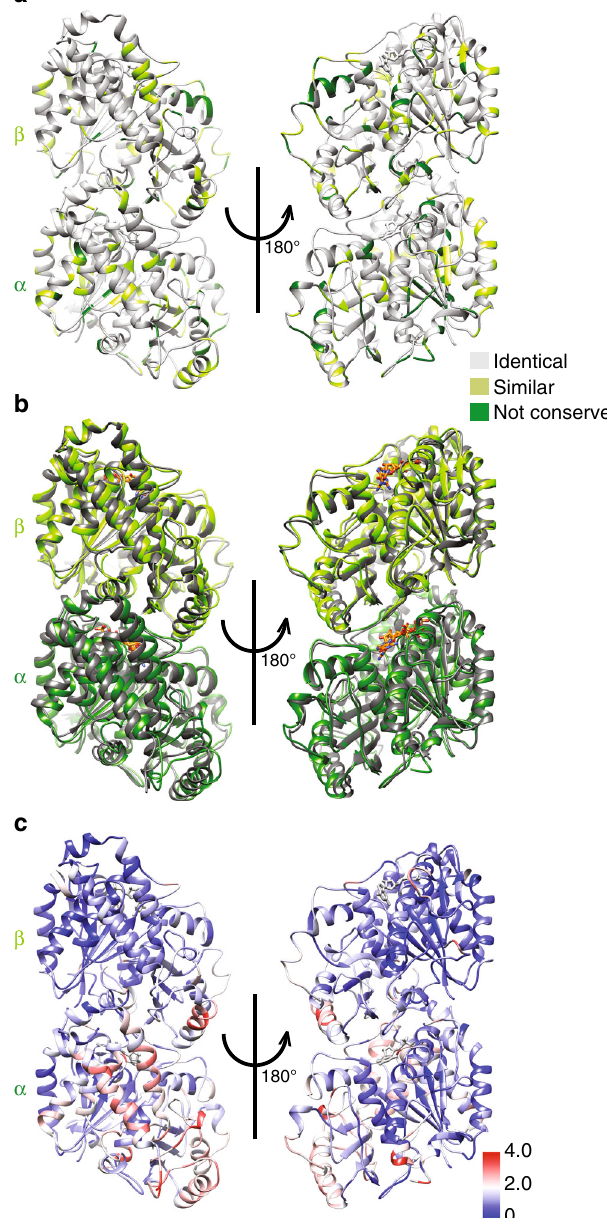
Fig. 3 Structure of Sp_tub dimer. a The Sp_tub dimer structure viewed from the MT outside (left) and inside (right) colored according to sequence conservation with mammalian tubulin. b The Sp_tub dimer structure (light green/dark green) overlaid on mammalian tubulin (gray) aligned on the central β -sheet of β -tubulin (PDB 3JAR) viewed from the MT outside (left) and inside (right). c The Sp_tub dimer structure colored according to structural differences (RMSD/Å) compared to mammalian tubulin as depicted in viewed from the MT outside (left) and inside